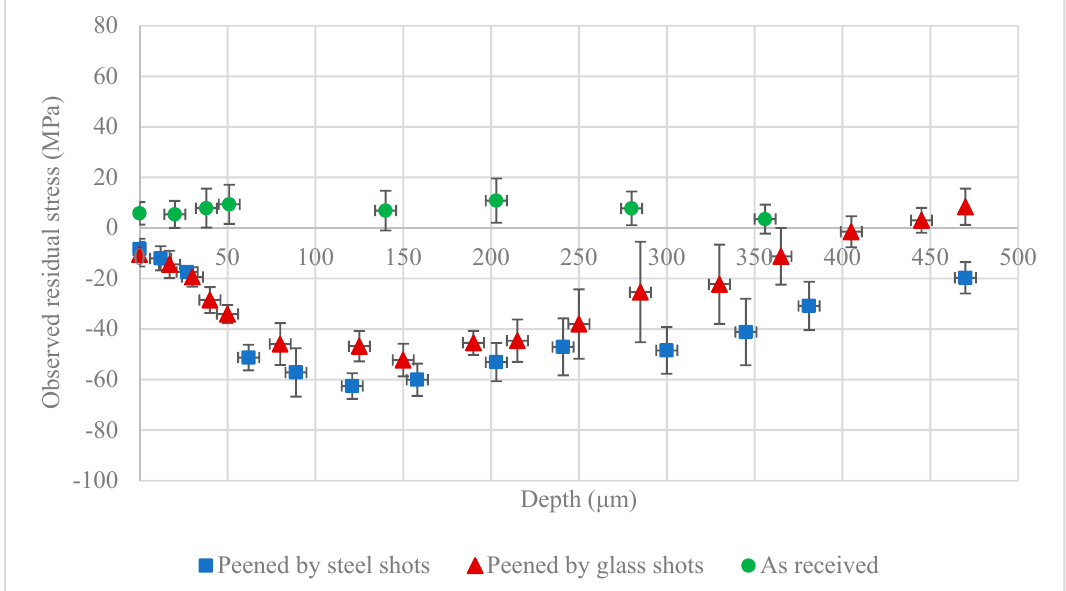
Figure 6. Observed (before proposed stress correction) residual stress on as received AZ31B-H24 plate and after shot peening with steel and glass shots.